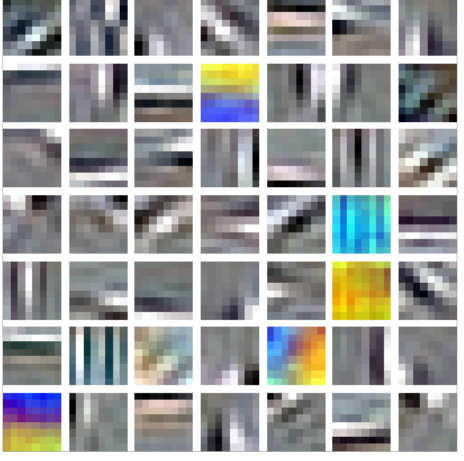
Figure 3. Filter bank obtained using feature learning. The learning algorithm has automatically generated filters that extract edge information (the grey-scale filters), colour information (the coloured filters) and texture information.